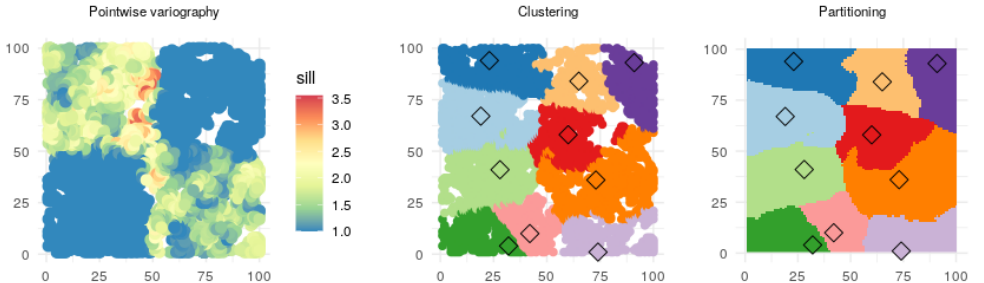
Figure 6. EDISON partitioning of data. The sill values of the pointwise variograms ( left panel ) clearly identify the boundaries between the four data-generating processes. Subsequent clustering ( middle panel ) finds those boundaries reasonably well. In the inference state, new observations can be partitioned among the clusters ( right panel ).